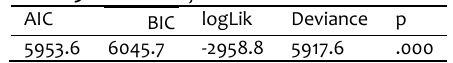
Table 5. Fit indices of the second